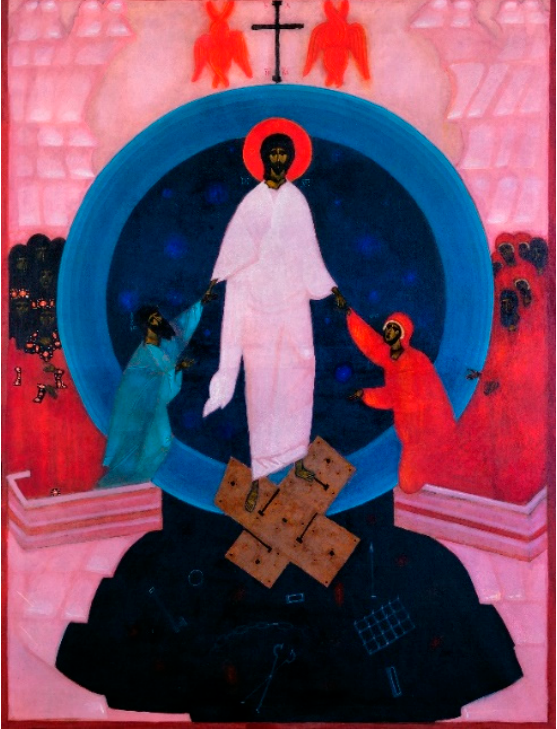
Figure 19. Jerzy Nowosielski Anastasis, 1978, Orthodox Church of the Dormition of the Blessed Virgin Mary, Kraków. Photography by the author. Reproduced with permission.